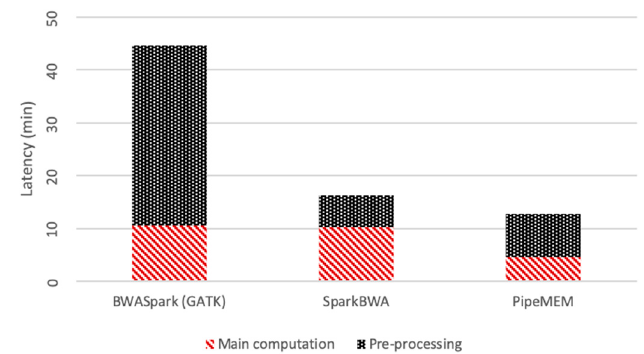
Figure11. Comparisonoftheintegratedprograminsevennodes. Thepre-processingofBWASparkistoo Figure 11. Comparison of the integrated program in seven nodes. The pre-processing of BWASpark longcomparedwiththetimeconsumedbyitsmaincomputation. is too long compared with the time consumed by its main computation. PipeMEM spends a relatively long time in the pre-processing compared with SparkBWA, but PipeMEM is faster, even including pre-processing.